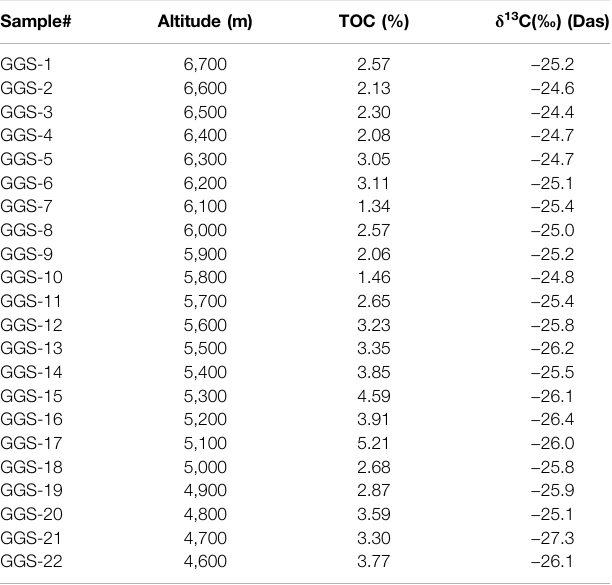
TABLE 1 | Results of TOC/ δ 13 C( ‰ ) analysis and calculated parameters of samples at Gongga Mountain.